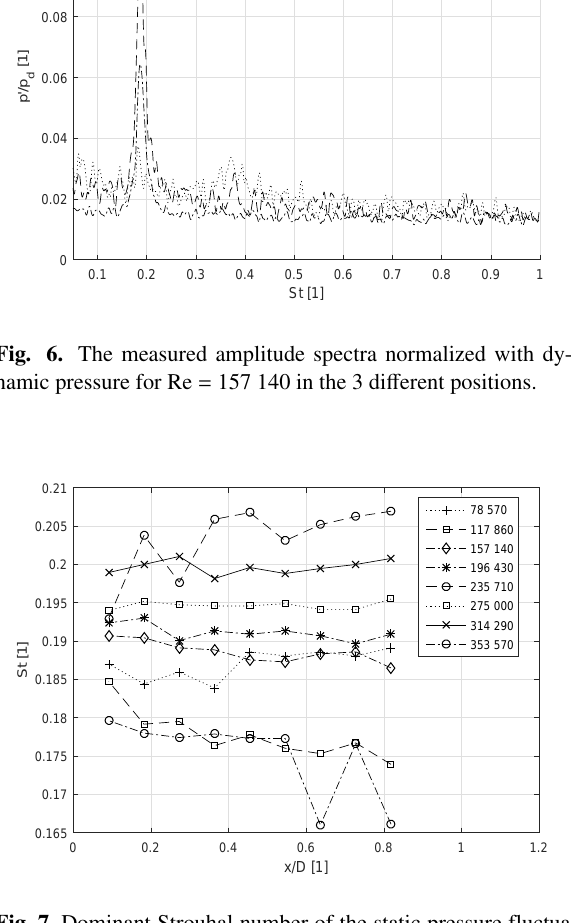
Fig. 7. Dominant Strouhal number of the static pressure fluctua- t ions in relation to position x / D for 8 di ff erent Reynolds numbers